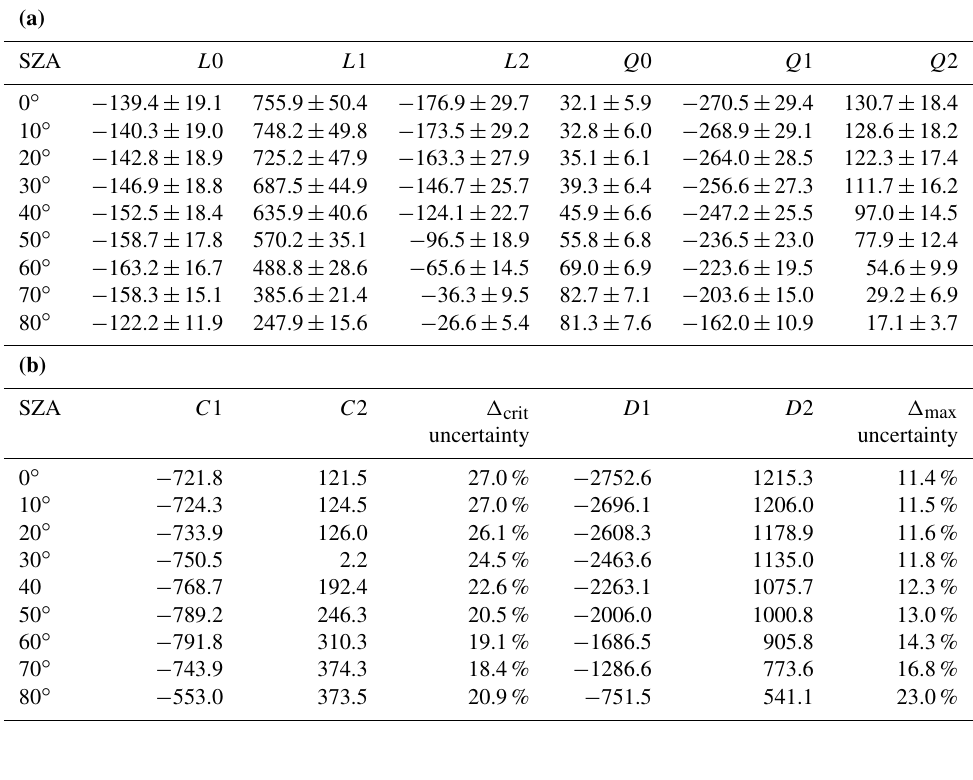
Table 4. (a) P DARE parameterization coefficients for differing SZAs. The collection of the coefficients represents the mean of all cases and the uncertainty values represent the standard deviation; the units on the L coefficients are Wm − 2 /unit optical depth; the units on the Q coefficients are Wm − 2 /(unit optical depth) 2 . (b) PX DARE additional coefficients for differing SZAs and their associated standard deviation, derived from the covariance matrix of the polynomial fits of Fig. 8a and b. These coefficients are used in Eqs. (22) and (23) (inserted into Eq. 24) and act as an extension to P in order to resolve the case-to-case variability resolvable through SSA. The units on the C 1 and D 1 coefficients are Wm − 2 /unit optical depth; the units on the C 2 and D 2 coefficients are Wm − 2 /(unit optical depth) 2 . The uncertainty columns represent the relative uncertainty of the delta correction terms. These uncertainties are applicable to Eqs. (22) and (23) and can be further propagated into Eq. (24).